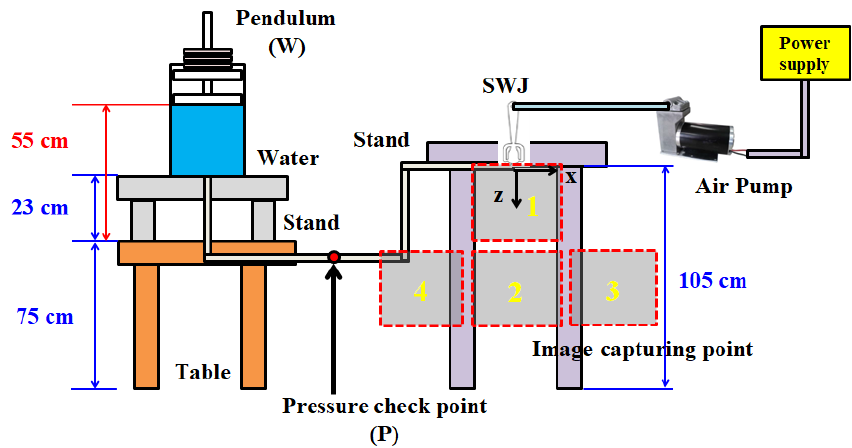
Figure 3. Schematic of the experimental setup for measuring the spraying performance.